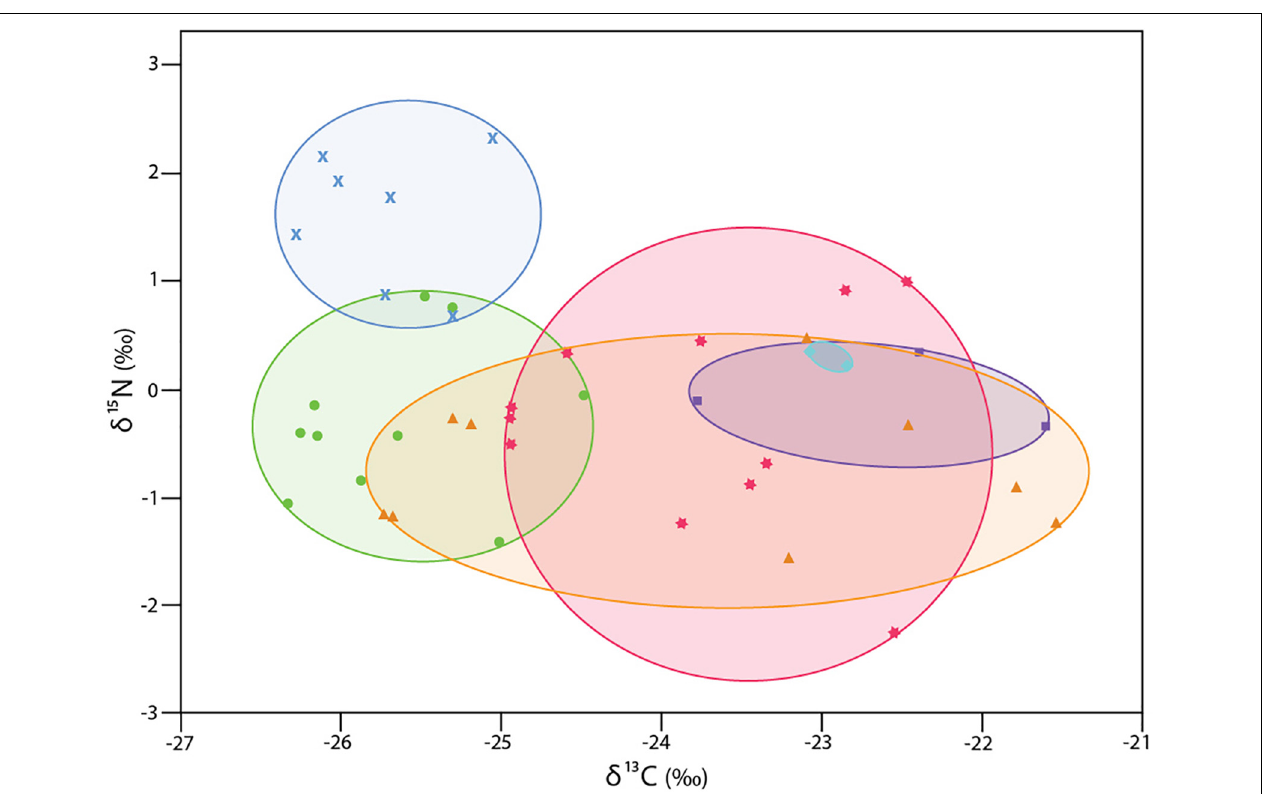
FIGURE 2 | δ 13 C and δ 15 N values for 42 specimens of Xylophaga s.l. zierenbergi from six deployments. wood bundles (WB) except aqua diamonds: from Douglas fir on Endeavour Segment, Juan de Fuca Ridge at 2211 m depth (Voight, 2007); all others are from deployments near Monterey Canyon at 3100 m depth (Judge and Barry, 2016): blue crosses bark-covered pine log (WB17); green circles bark-covered oak log (WB23); orange triangles gingko logs (WB26); pink stars spicebush sticks (WB19); purple squares island ironwood